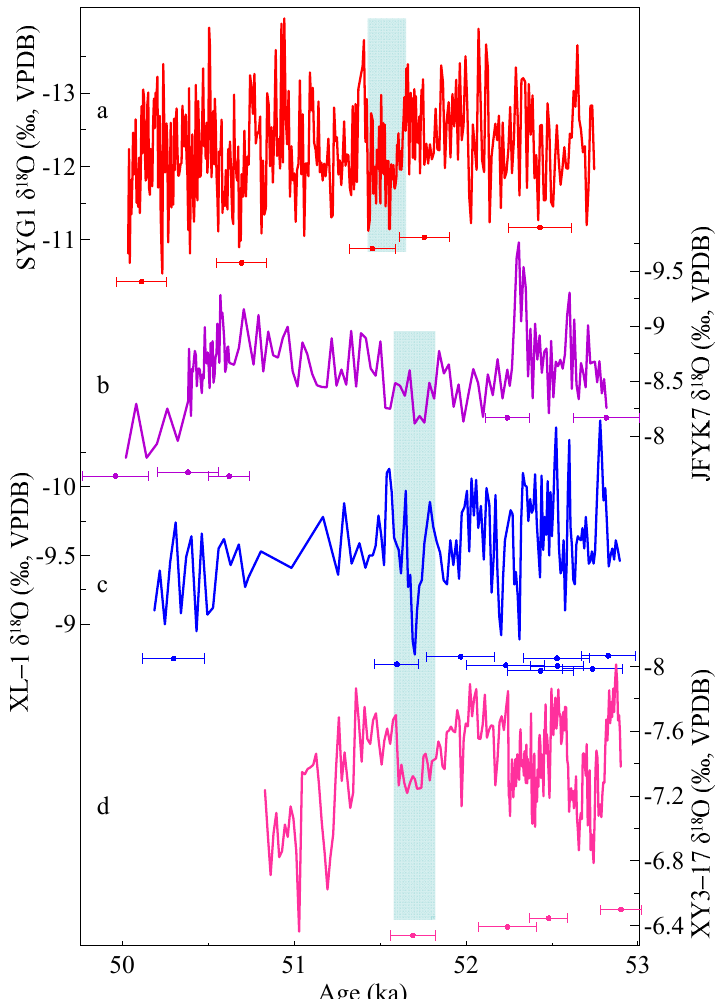
Figure 4. Comparison of our δ 18 O record with other Chinese speleothem records. From the top to bottom are ( a ) SYG1 δ 18 O (red line, this study) and ( b ) δ 18 O record from Yangkou Cave [24] (purple line), ( c ) δ 18 O record from Xinglong cave [23] (bule line) and ( d ) δ 18 O record from Xianyun Cave [25] (pink line). The light blue bar denotes the most evident centennial ‐ scale fluctuations.